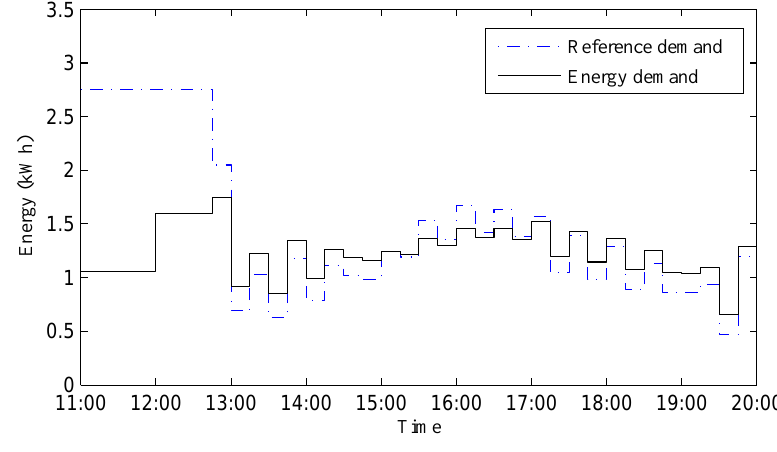
Figure 5. Optimal energy demand of the TCL.